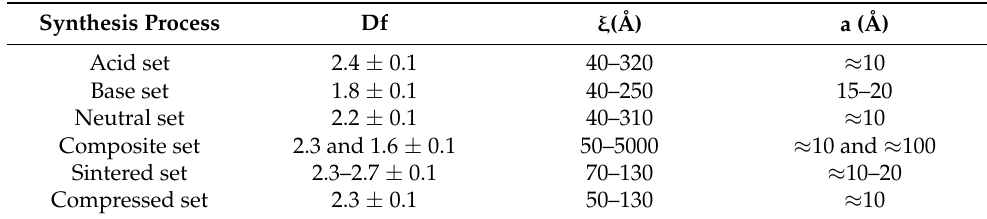
Table 2. Main results concerning the fractal structure of silica aerogels: base, neutral and acidic catalysis, composite, sintered and compressed sets.